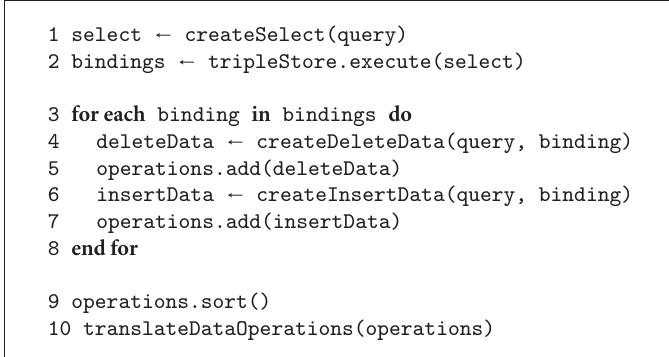
Algorithm 2: SPARQL DELETE/INSERT operations to HTTP requests translation algorithm.